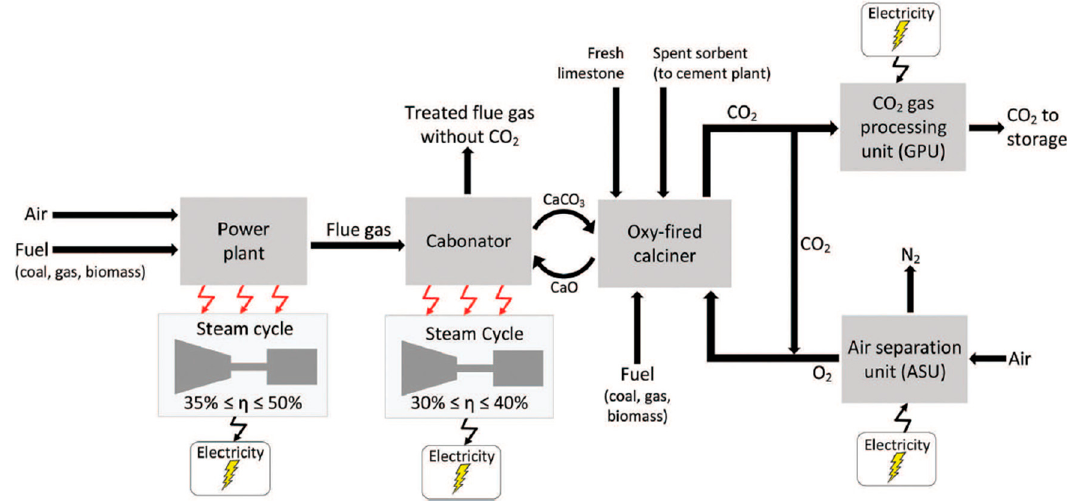
Figure 10. A schematic diagram of post combustion carbon capture using Calcium looping [82].